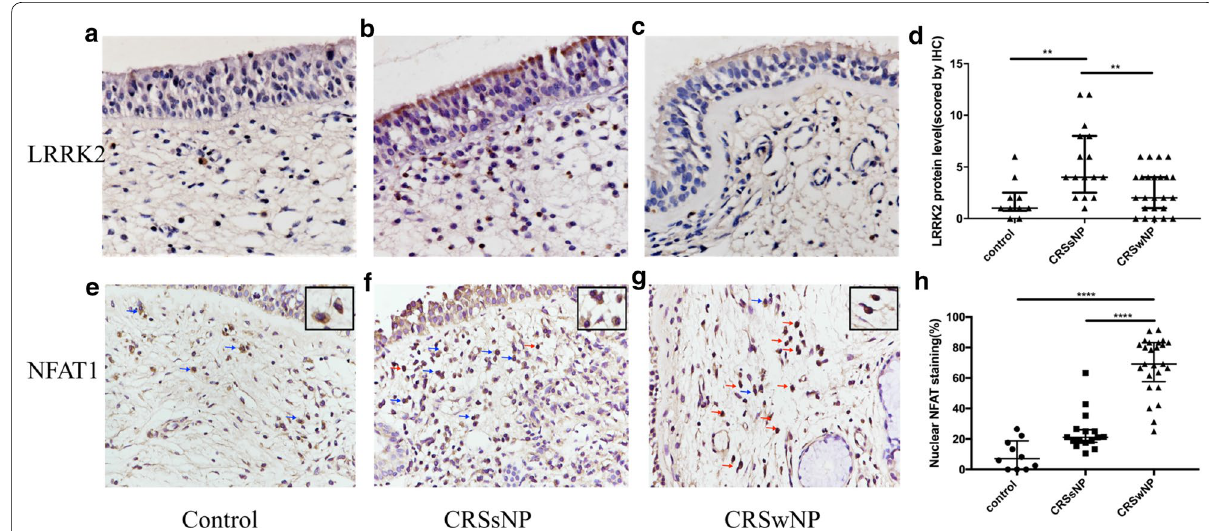
Fig. 2 LRRK2 inhibits NFAT1 nuclear translocation. ( a – c ; 400 magnification) LRRK2 expression and distribution in control, CRSsNP and CRSwNP × groups; d LRRK2 was significantly overexpressed in the CRSsNP group compared with the control group and CRSwNP group; ( e – g ; 400 × magnification) NFAT1 localization in control, CRSsNP and CRSwNP groups; blue arrows indicate cells with cytosolic NFAT1 staining, red arrows indicate cells with nuclear NFAT1 staining; the top right corner is an enlargement of immuno-positive cells; h the percentage of cells with NFAT1 nuclear staining was much higher in CRSwNP group compared with the control group and CRSsNP group. ** p < 0.01, **** p < 0.0001